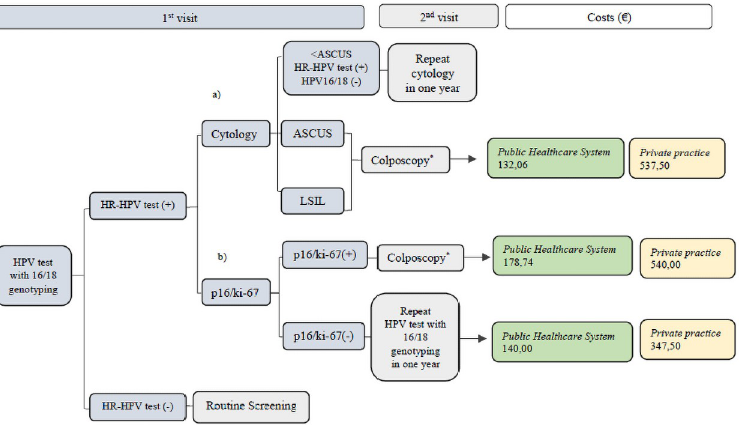
Fig 3. Second strategy: HPV test as primary screening test with 16/18 genotyping. Triage with a) Cytology b) p16/ ki-67dual stain. Cytology, LBC; Costs in Euros ( € ), direct medical costs (screening tests, colposcopy with biopsy and office visit) per woman screened; costs for annual follow-ups and treatments for CIN were not included. � Colposcopy with biopsy.